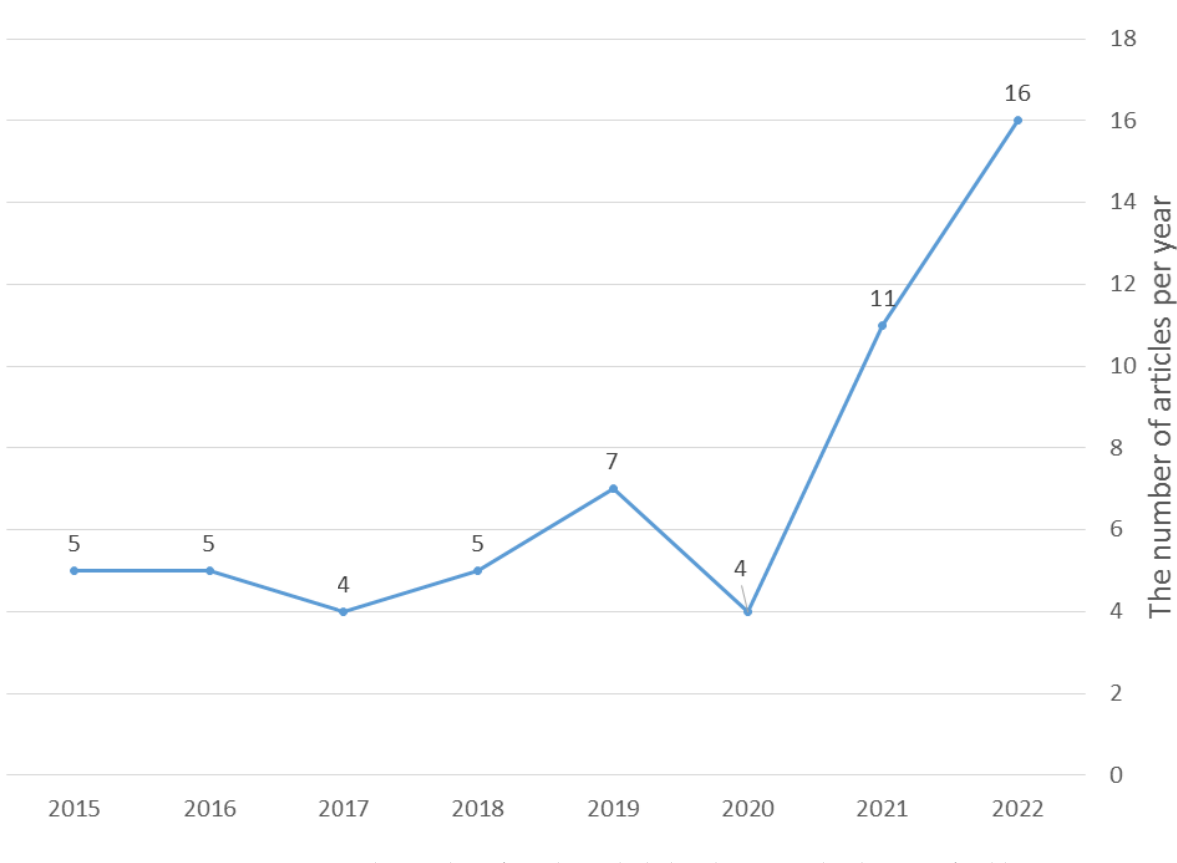
Figure 2. The number of articles included in this review by the year of publication.